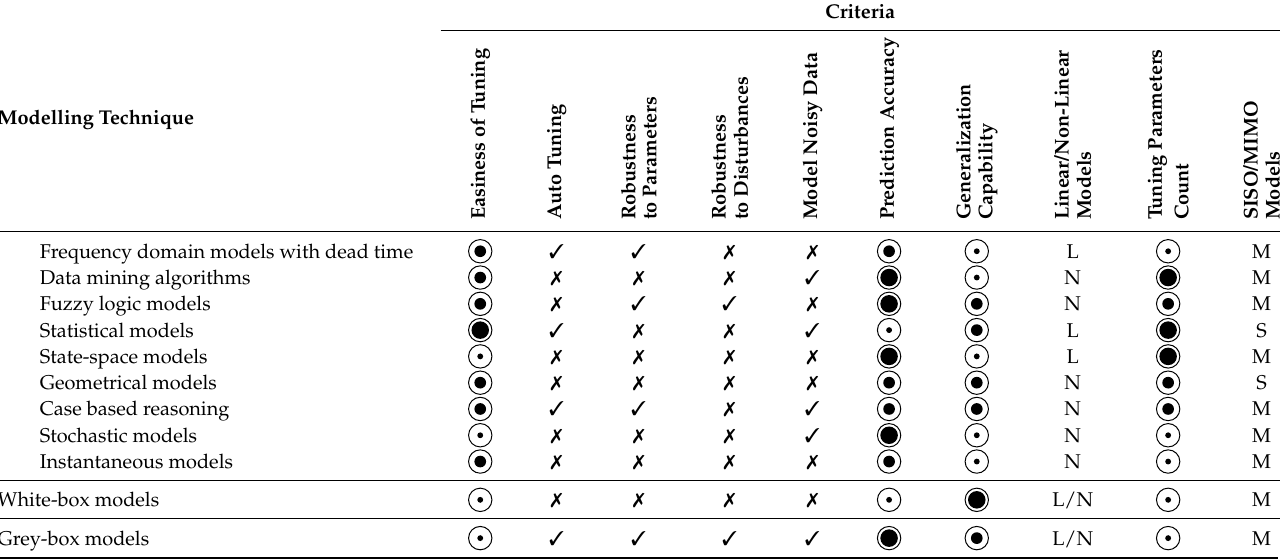
Table 1. Comparison of modelling techniques for HVAC systems